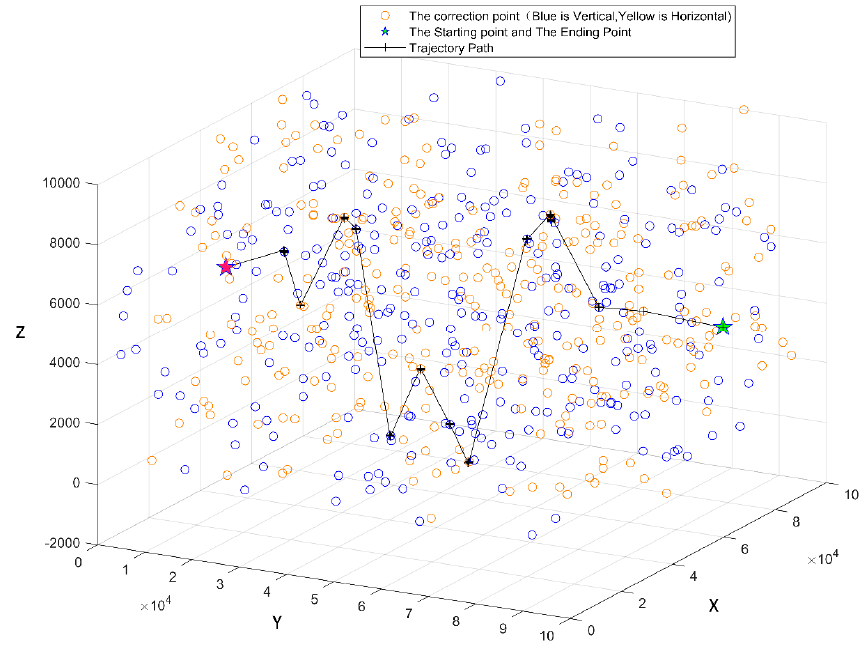
Figure 11. Trajectory planning path for the Problem 2.